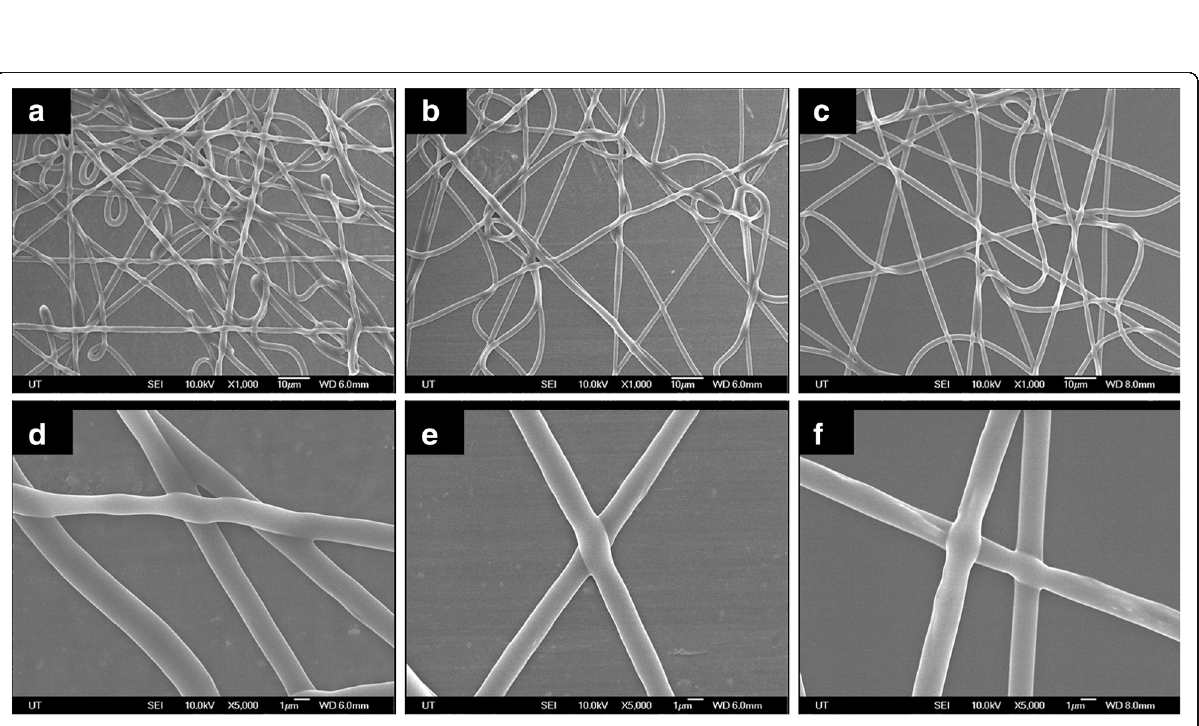
Fig. 4 SEM images of electrospun fiber under different conditions with a tip-to-electrode distance of 8 cm and applying 12 kV DC voltage. a , d Conventional electrospinning — metal electrode without local humidity control. b , e Metal electrode with local humidity control. c , f Hydrophilic surface polymer substrate with local humidity